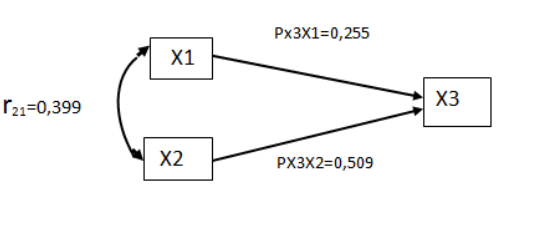
Figure 2. Testing model of the direct effect of X1 and X2 on